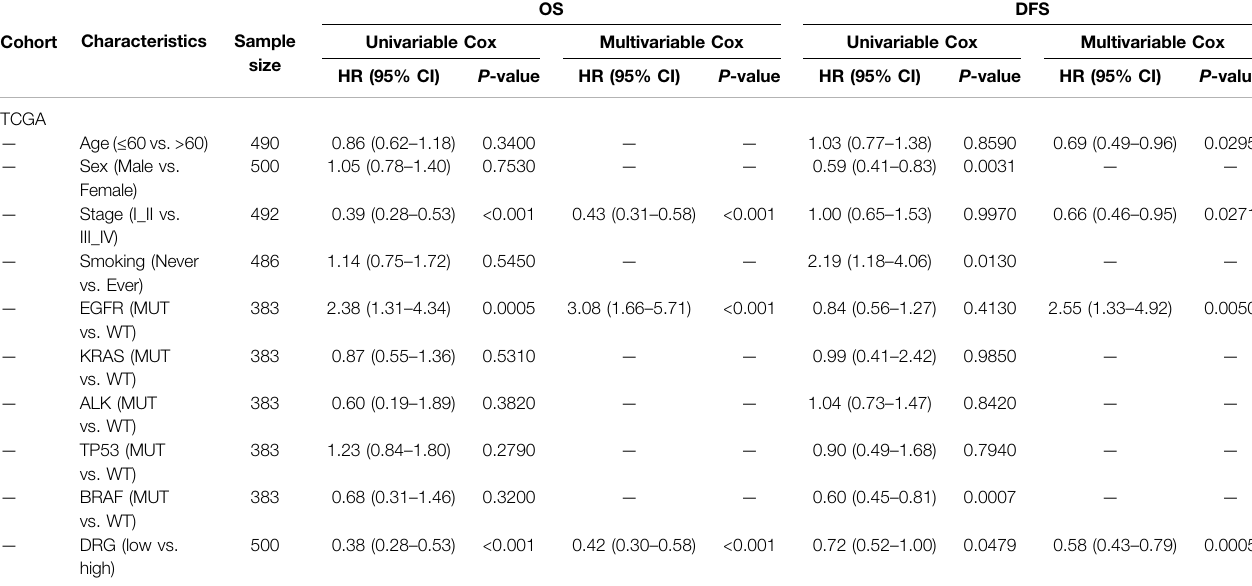
TABLE 1 | Univariable analysis and multivariable Cox regression analyses of OS and DFS in TCGA cohorts.